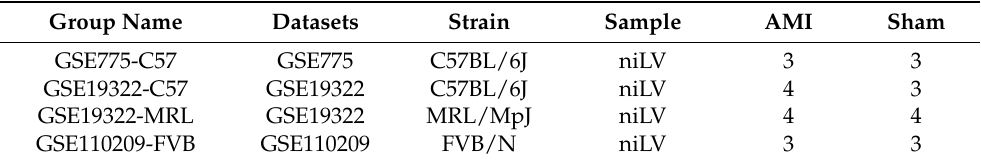
Table 1. Compositions of individual